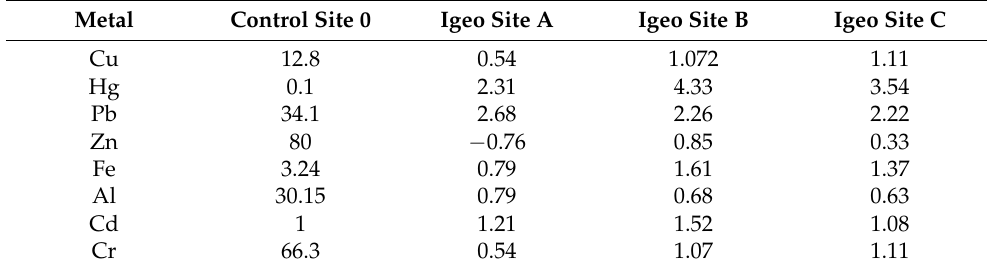
Table 2. Geo-accumulation indices.